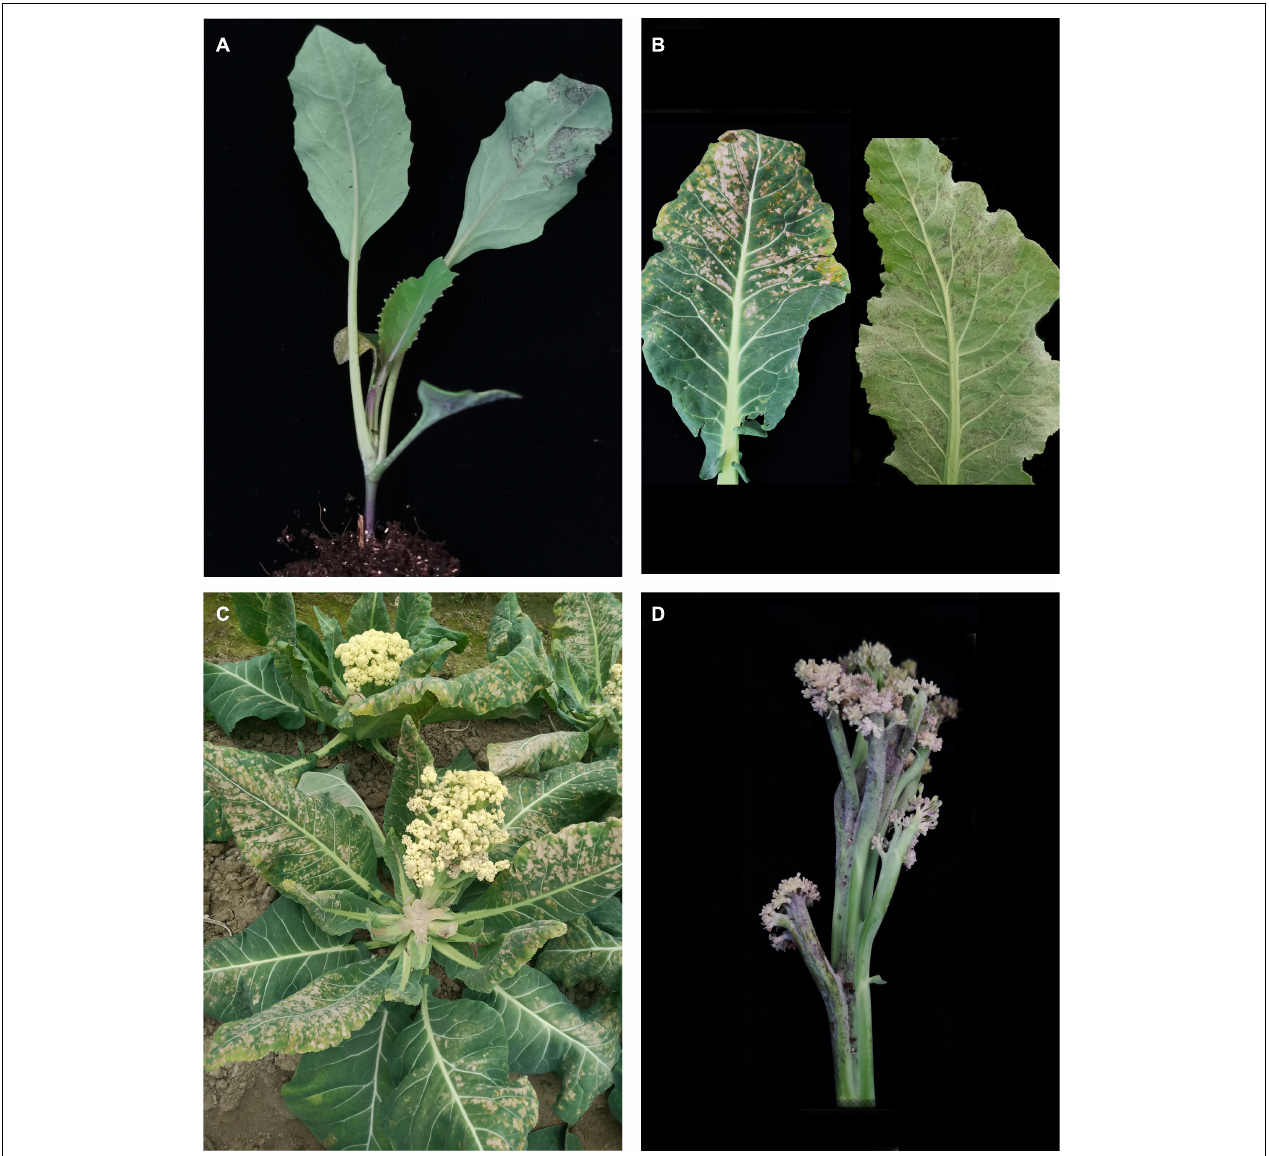
FIGURE 2 | Symptoms of downy mildew infection in cauliflower [ (A) seedling stage, (B) mature leaves during curding stage, (C) whole plant during bolting stage, (D) stalk of the